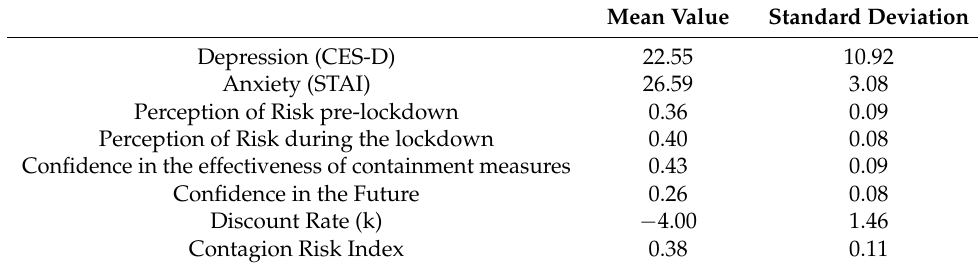
Table 1. Mean values and standard deviations of the relevant measures collected in the survey.